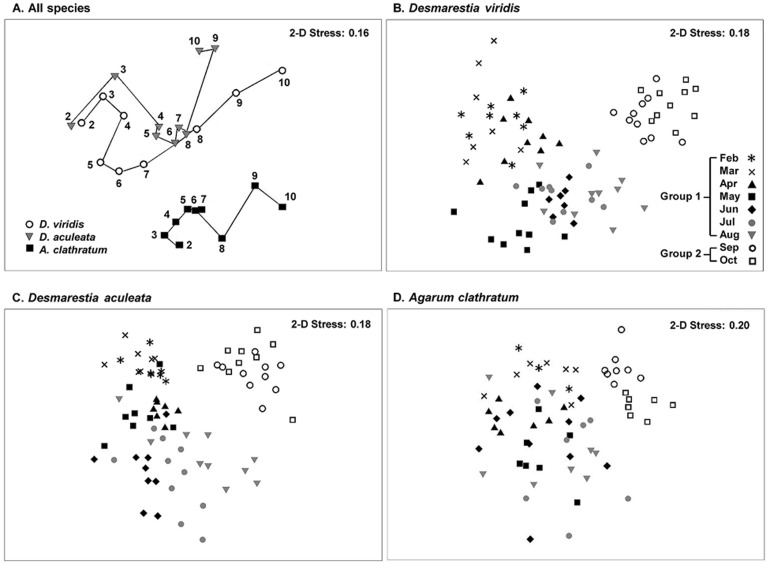
Non-metric multidimensional scaling (nMDS) plots of Bray-Curtis similarities of Desmarestia viridis, Desmarestia aculeata, and Agarum clathratum based on associated epifauna (4th-root transformed density, individuals g−1 of seaweed) from 18 February to 9 October, 2011 at Keys Point.(A) Each data point is the average of samples for a given month [n = 7 to 10, except 3 for A. clathratum in February, for a total n = 221]. The trajectory of change for each seaweed is shown by solid lines connecting consecutive months. Numbers next to symbols indicate sampling month: February (2), March (3), April (4), May (5), June (6), July (7), August (8), September (9), and October (10). (B, C, D) Each data point is one sample within a given month (n =  80 [D. viridis], 77 [D. aculeata], and 64 [A. clathratum]). Group 1 and Group 2 designate clusters of months used in ANOSIM and SIMPER analyses (see Results).